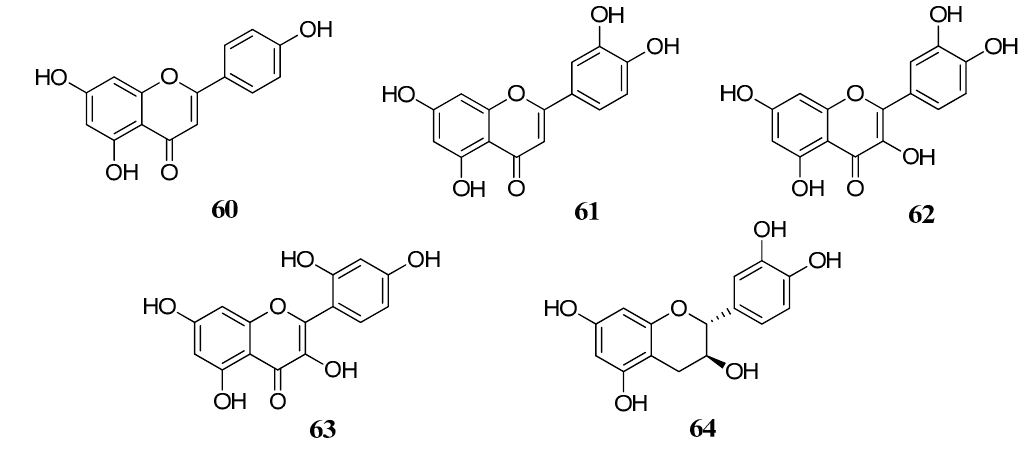
Figure 13. Structures of compounds 60 – 64 .